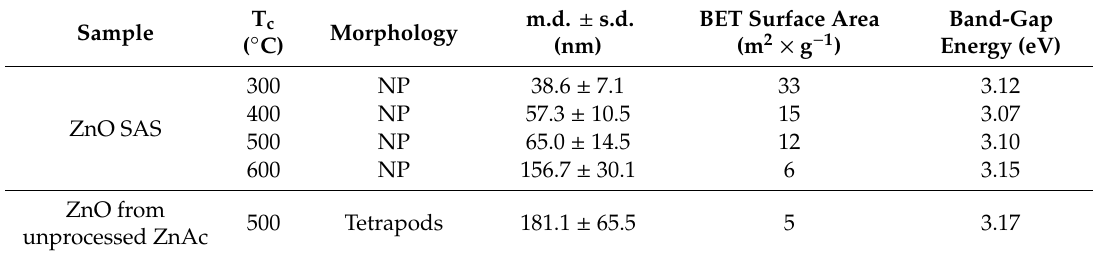
Table 1. Summary of the experimental results (T c = calcination temperature; NP = nanoparticles; m.d. = mean diameter; s.d. = standard